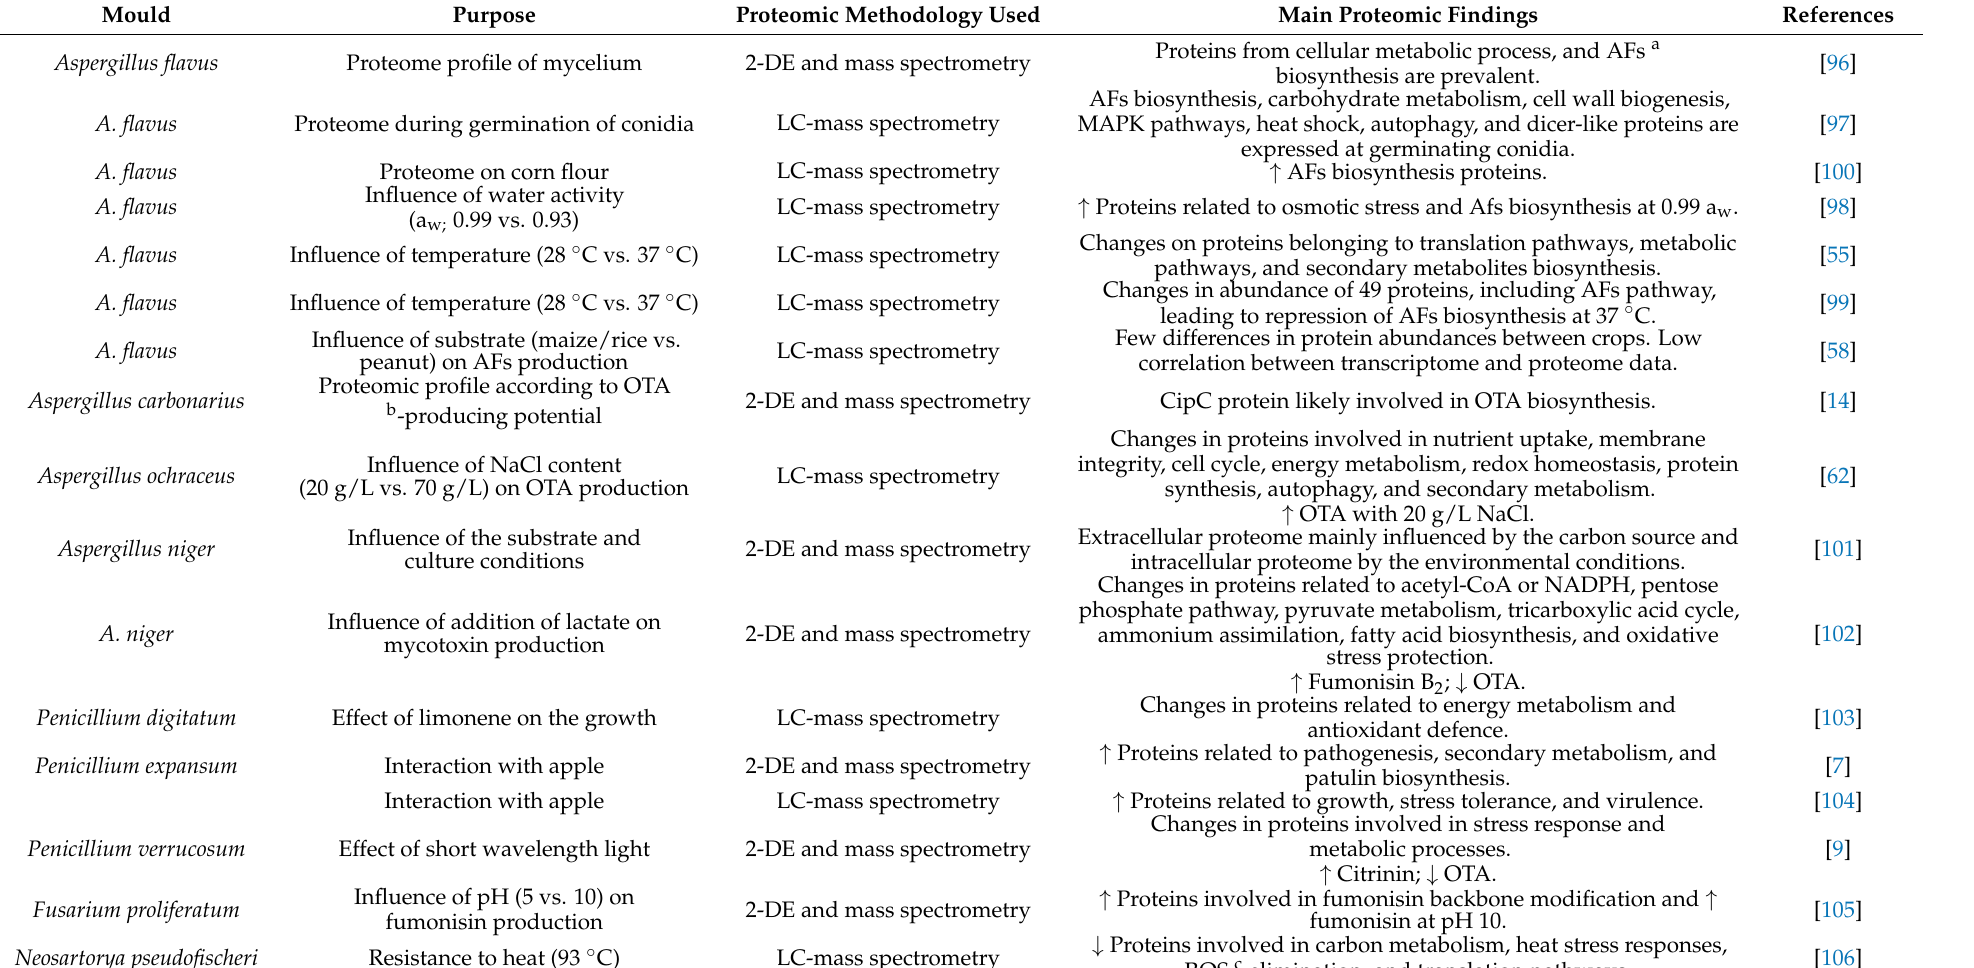
Table 2. Proteomic studies on mechanisms of mould growth and mycotoxin